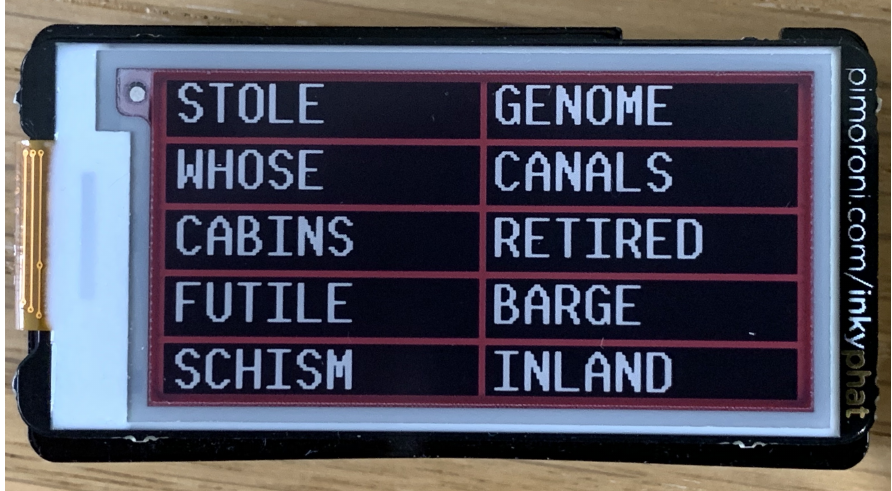
Figure 3. An example IoT device—built from a Raspberry Zero W fitted with a three-colour eInk